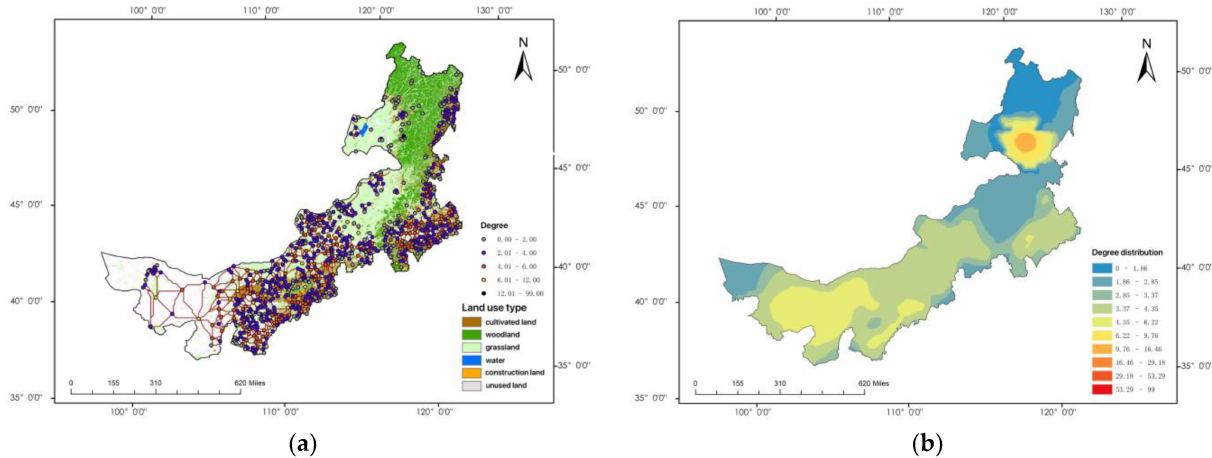
Figure 8. ( a ) Node degree spatial distribution; ( b ) spatial distribution